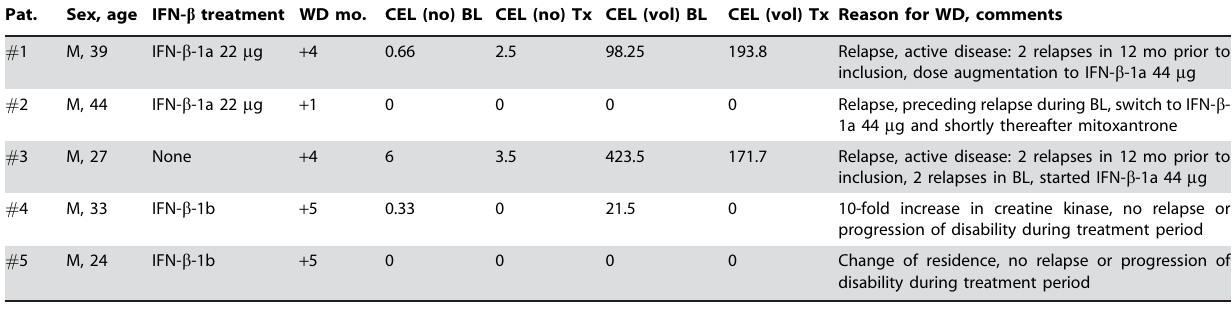
Table 4. Clinical characteristics and MRI data of patients with premature study withdrawal.